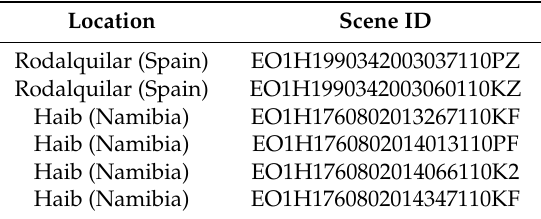
Table A1. Hyperion data used in this